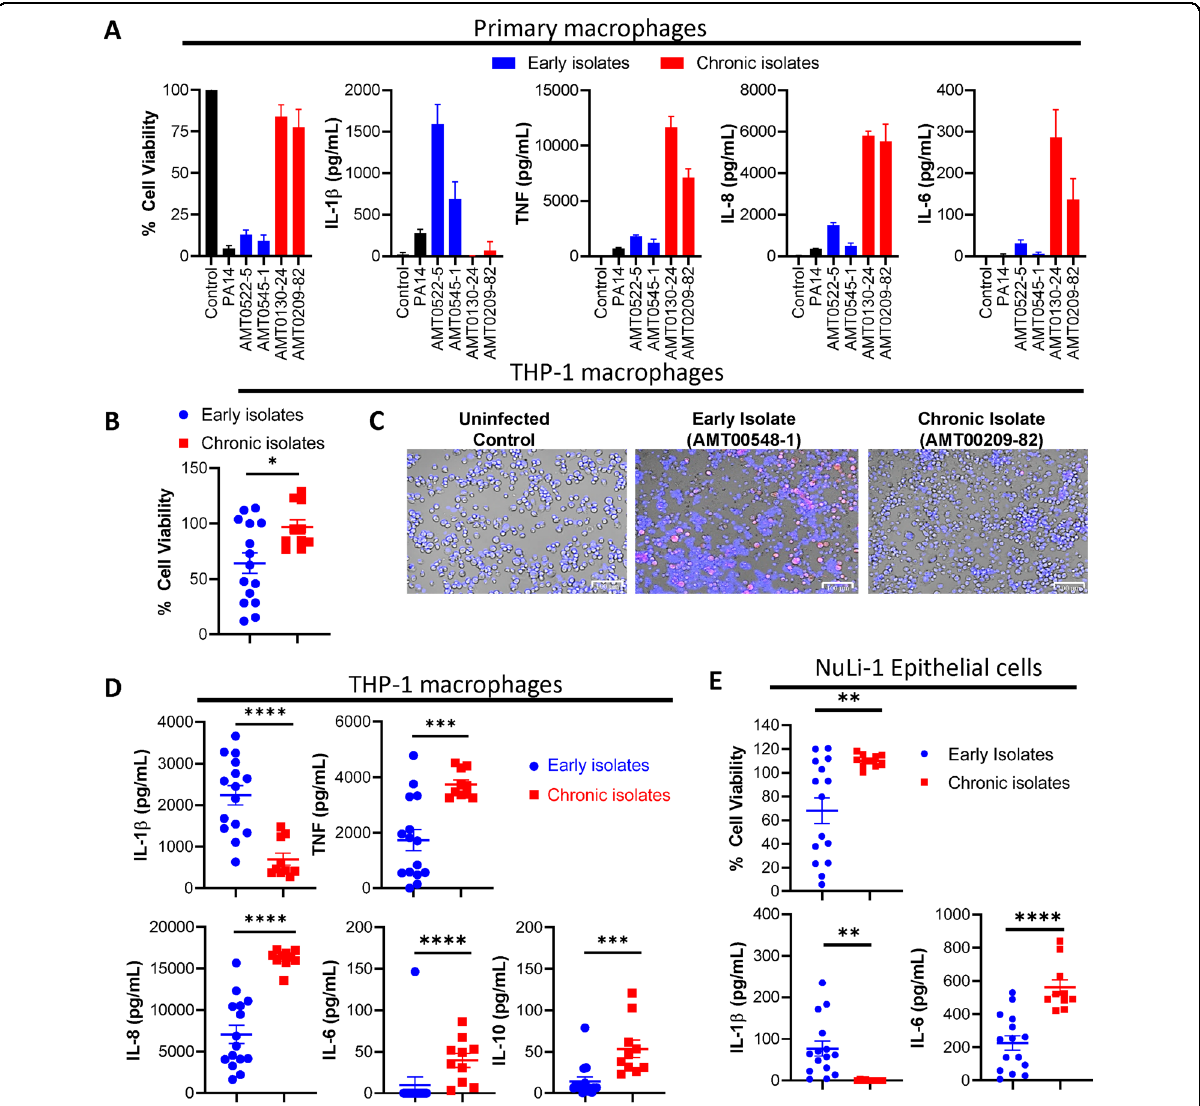
Fig. 1 P. aeruginosa isolates from chronic CF infections induce less cell death but increased expression of TNF, IL-8, and IL-6 compared with early isolates. Early isolates were de fi ned as isolates from the fi rst positive P. aeruginosa -positive sputum culture, while chronic isolates were from patients who had 4 years of positive sputum cultures. Primary human macrophages were seeded at 50,000 cells/well and infected with the indicated early and chronic isolates of P. aeruginosa from early and chronic infections or PA14 (10 MOI). Cell viability was measured via neutral red assay and cytokine production was measured via ELISA at 3 h postinfection ( A ). THP-1 macrophages were seeded in fresh media at 100,000 cells/well in a 96-well plate and infected with P. aeruginosa isolates from CF patients with early or chronic respiratory infections at 1 MOI as described in Methods and in experimental triplicates. At 3 h postinfection, cell viability was evaluated by neutral red assay, and cytokine production was measured in the supernatants by ELISA ( B , D ). Student ’ s t-tests were used to compare the means for cell viability, TNF, and IL-8 while Mann – Whitney U tests were used for IL-1 β , IL-6, and IL-10. THP-1 macrophages were seeded at 500,000 cells/well and infected with P. aeruginosa (early or late isolate) at 10 MOI. At 2 h postinfection, cells were stained with Hoechst/PI to distinguish live (blue) from dead (pink) cells ( C ). NuLi-1 bronchial epithelial cells were seeded at 30,000 cells/well in a collagen-coated 96-well plate and infected with the same cohort of early and chronic P. aeruginosa isolates at 100 MOI and in experimental triplicates. Cell viability via neutral red assay and cytokine production in supernatants via ELISA were measured 6 h postinfection ( E ). Mann – Whitney U tests were used to compare IL-1 β and IL-6 while Welch ’ s t -test was used to compare the means for cell viability. Mean ± SD of triplicates of a representative, or a pool of >3 experiments are shown. (* P < 0.05, *** P < 0.001, **** P <